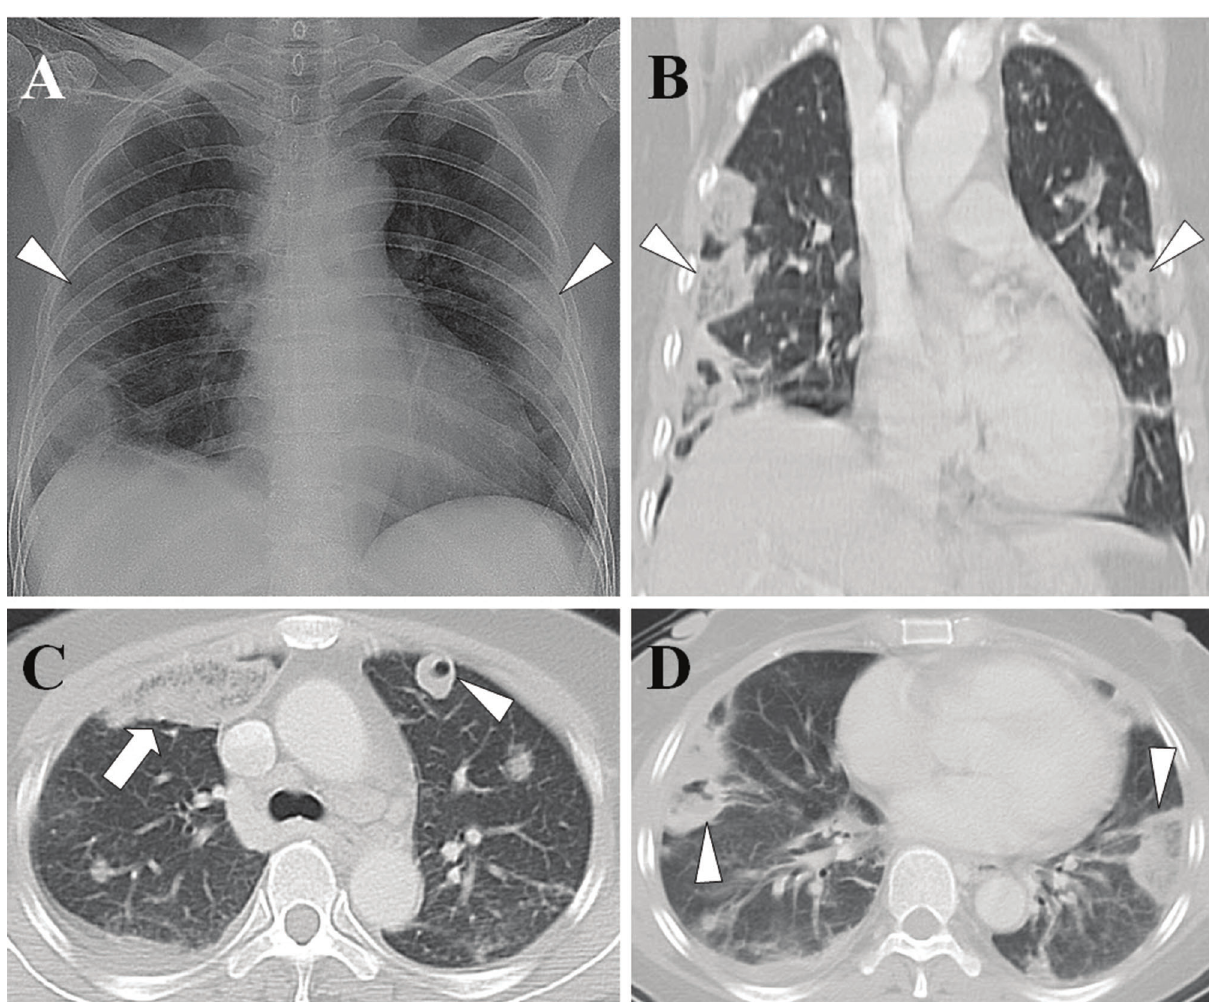
Figure 3 - Tricuspid valve infective endocarditis with septic pulmonary emboli. (A) A chest radiograph shows multiple peripheral patchy opacities in the bilateral lungs (arrowheads). (B) A lung window of a coronal CTscan shows multiple peripheral wedge-shaped opacities (arrowheads). (C) A lung window of a cross-sectional CTscan shows a ground-glass opacity in the right upper lobe (arrow) and a nodule with cavity in the left upper lobe (arrowhead). (D) A peripheral wedge-shaped opacity with central necrosis in the right lower lobe (arrowhead) and a peripheral wedge-shaped opacity without central necrosis in the left lower lobe (arrowhead). The patient was a 50-year-old woman whose blood cultures were positive for methicillin-susceptible Staphylococcus aureus